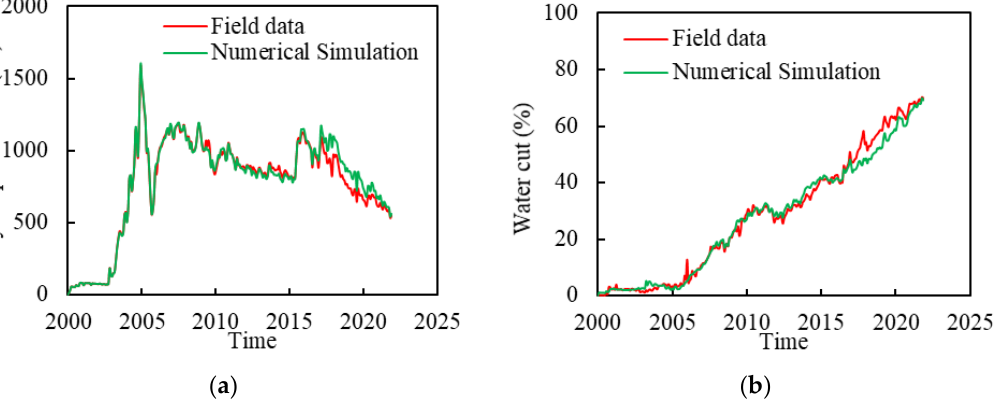
Figure 2. Production history of the Baoshaceng reservoir. ( a ) Daily oil production history fitting. ( b )Water cut history fitting